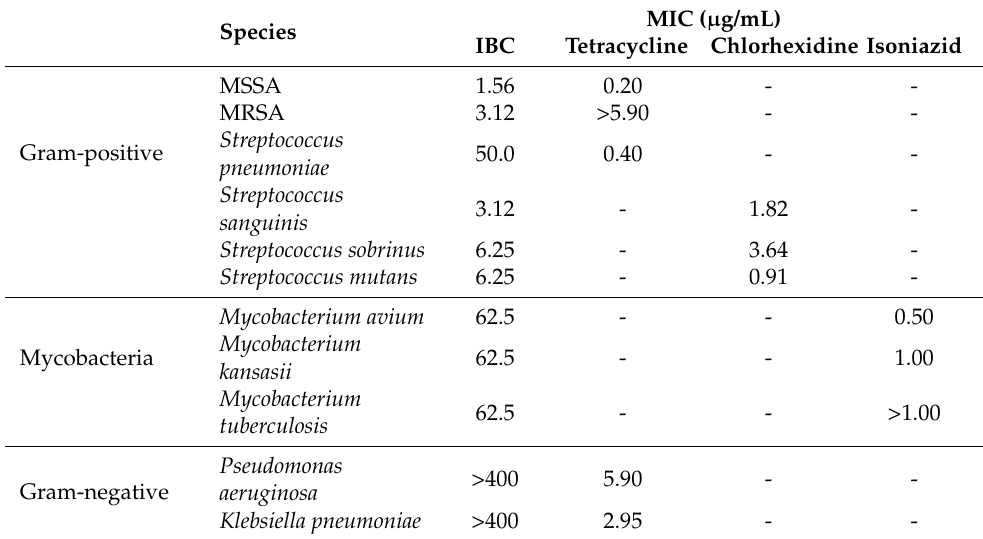
Table 1. Antibacterial and antimycobacterial activities of IBC .